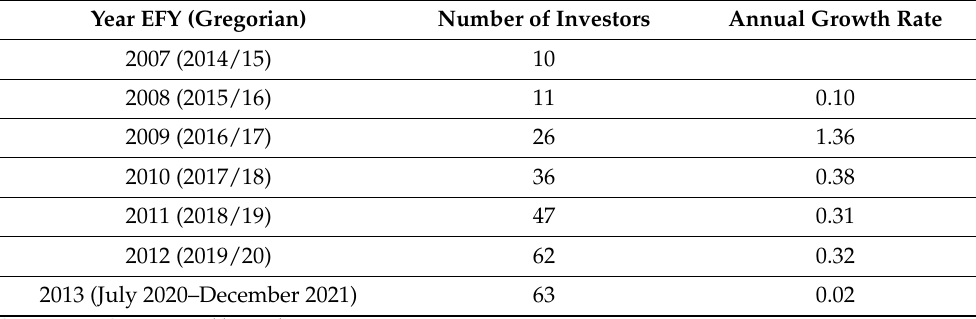
Table 5. Number of investors in IPDC-owned IPs